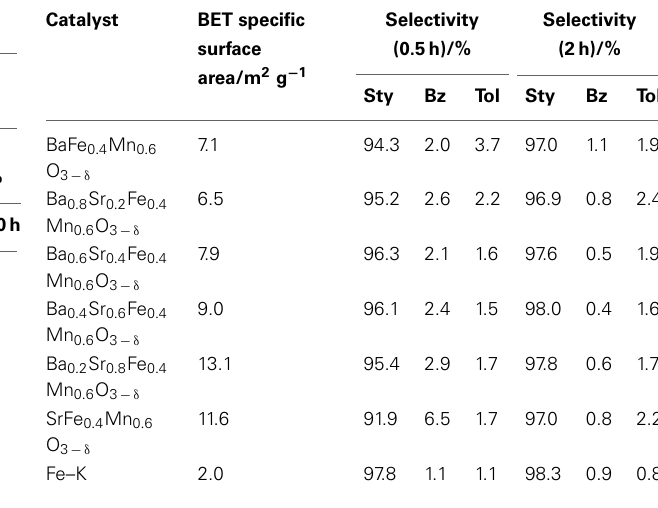
Table 4 | Selectivity to styrene, benzene and toluene for EBDH